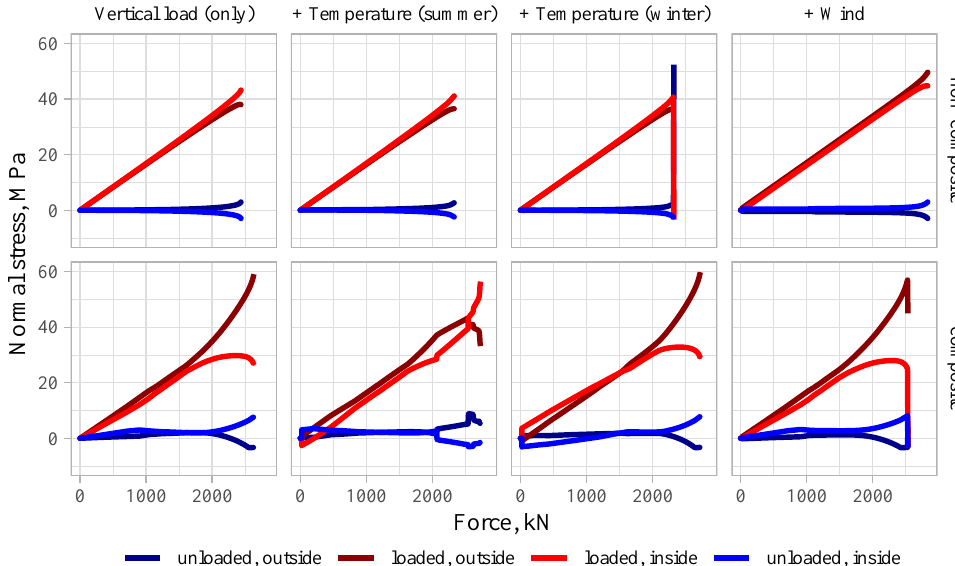
Figure 17. Stress on the surface of the wythes at the middle of the wall height-wise in the case of external walls. The compressive stresses are plotted positively.